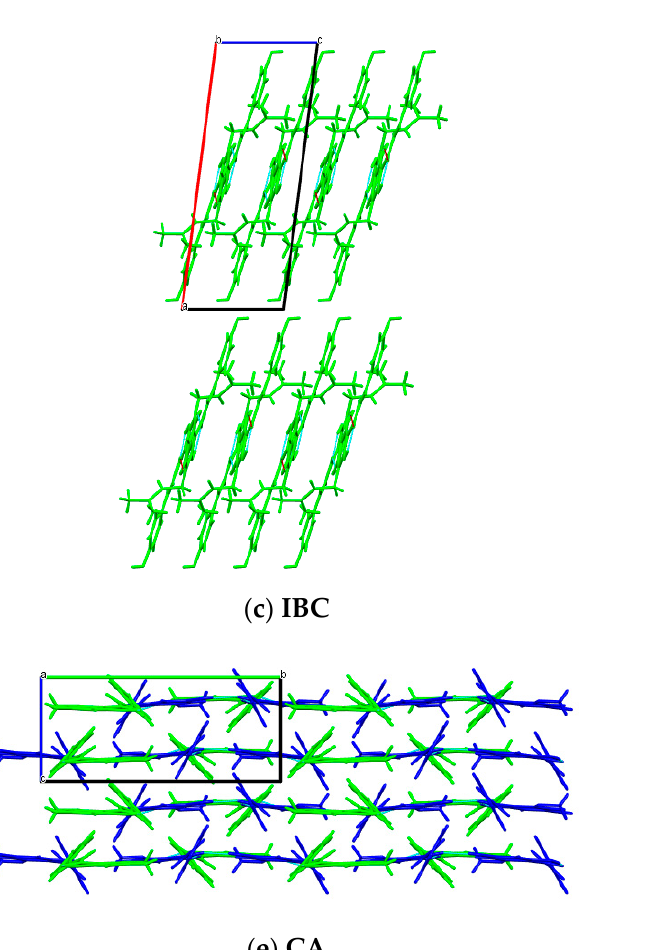
Figure 8. Crystal packing and interactions in the ( a ) HCH crystal—view along [010] direction, ( c ) IBC crystal—view along [010] direction and ( e ) CA crystal—view along [100] direction. The related dihedral angles in ( b ) HCH, ( d ) IBC and ( f ) CA.